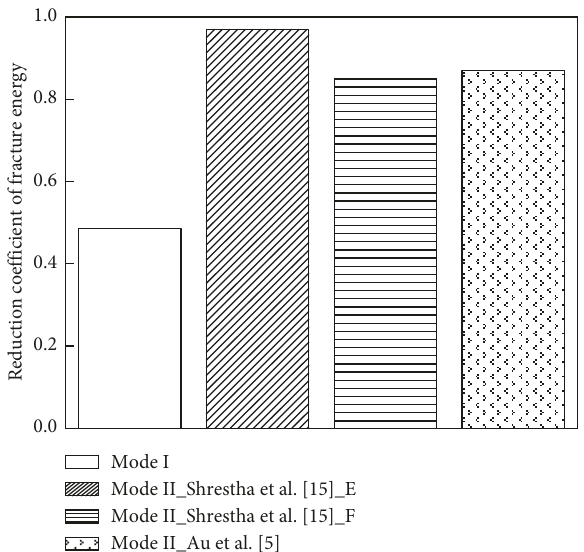
Figure 15: Comparisons of the mode I (peel) fracture energy and mode II (shear) fracture